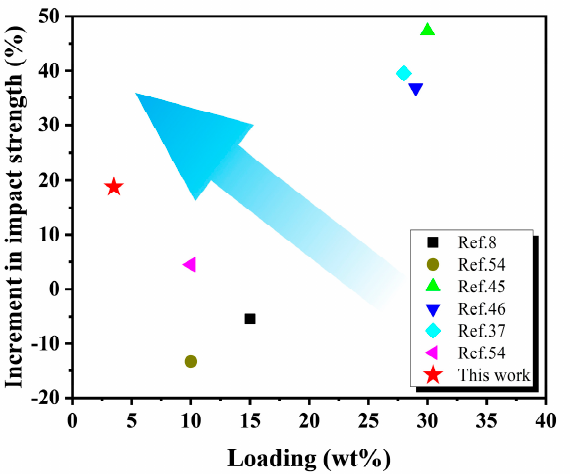
Figure 7. Comparisons of variation in impact strength and loading of PLA3.0 with previously reported flame-retardant and toughened PLA materials containing biofiber which achieved a UL-94 V-0 rating.